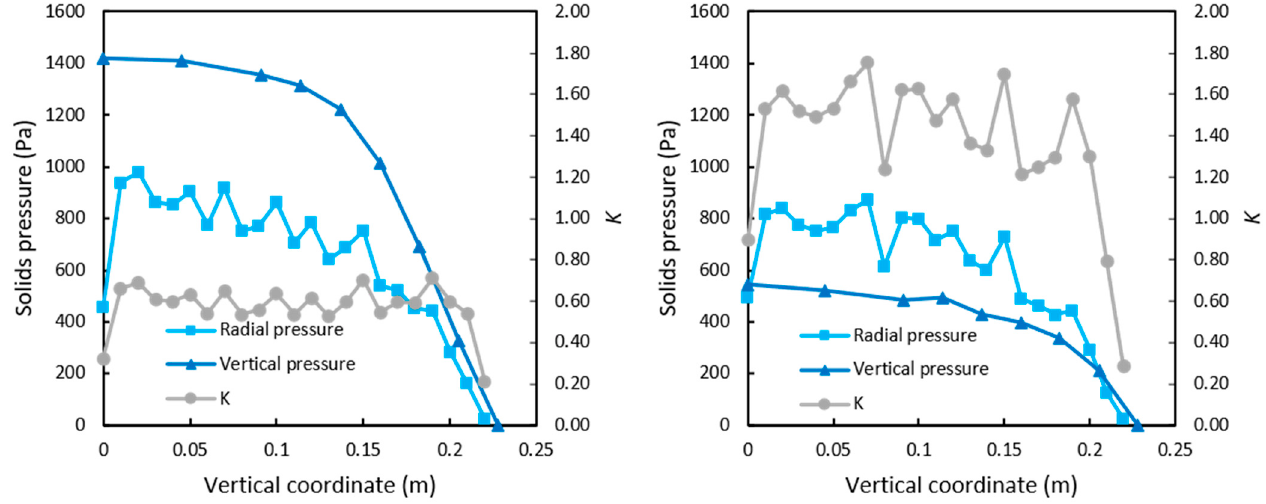
Figure 5. Solid pressure in the radial and vertical direction along the height of the column for Sim1 ( left plot ) and Sim2 ( right plot ).